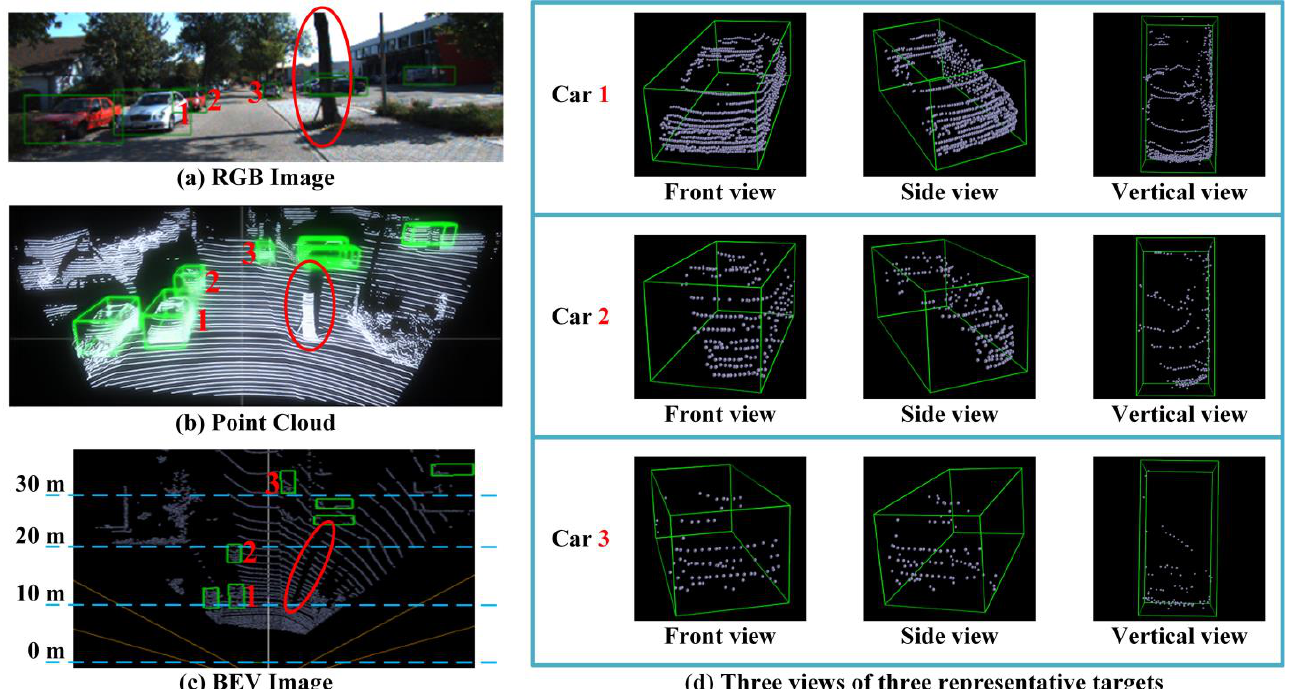
Figure 1. ( a ) is the RGB image of the autonomous driving scene, ( b ) is the point cloud obtained from the LiDAR scanning scene, ( c ) is the BEV (Bird’s Eye View) image of the point cloud, marking the distance between the object and the sensor. Mark Car 1, Car 2 and Car 3 represent the close target, occluded target, and long-range target, respectively. ( d ) shows the three views of these three targets. In 2D vision tasks, large-scale datasets (such as ImageNet [4]) are commonly